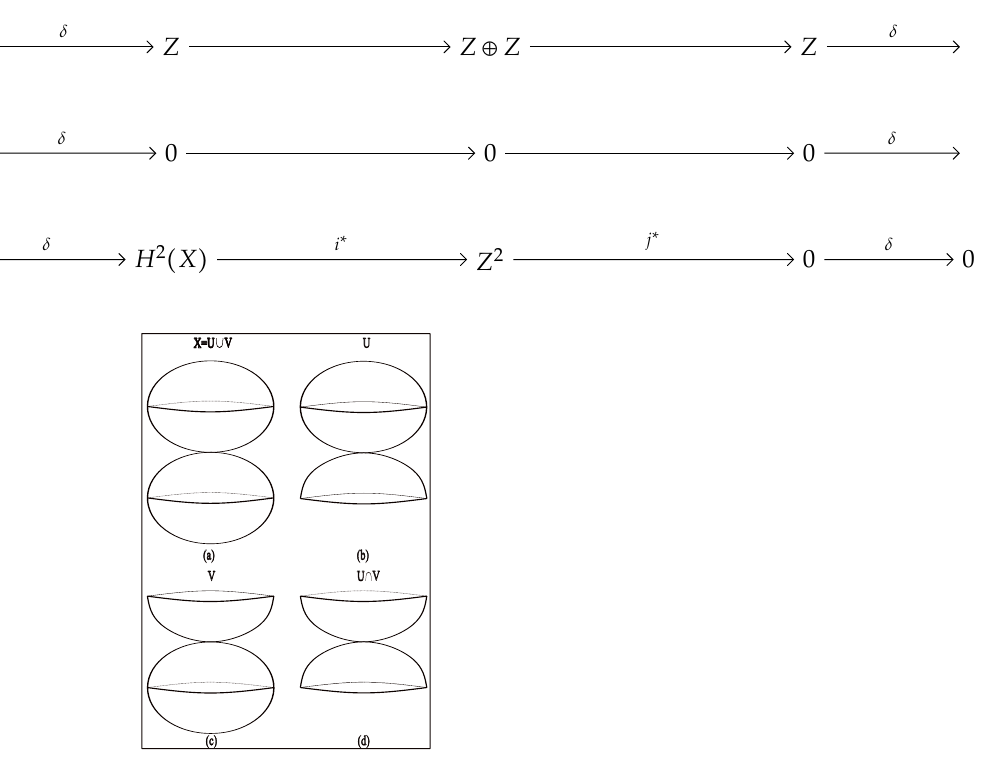
Figure A6. Open sets U and V for computing the cohomology groups of the space X. Therefore, the cohomology groups are: H 0 ( X ) = Z , H i ( X ) = 0 for i = 1 and i > 2, H 2 ( X ) = Z 2